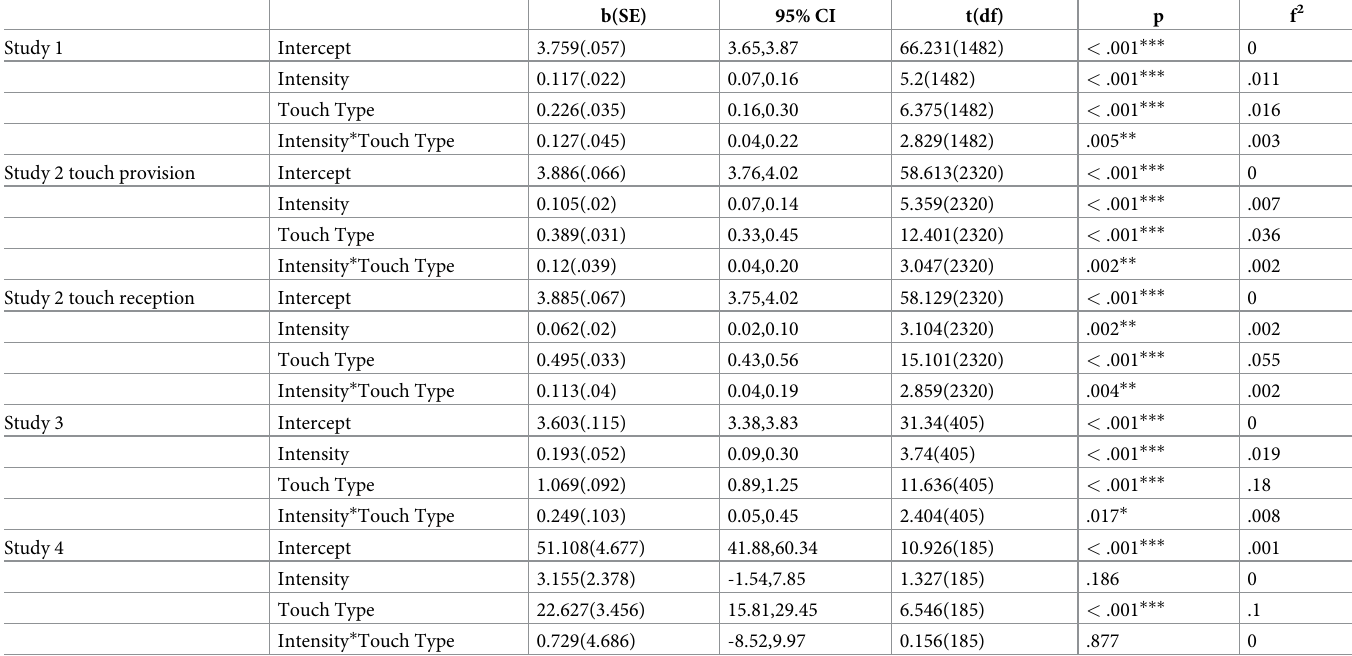
Table 4. The effect of situation intensity as measured by participant ratings and of touch type on touch